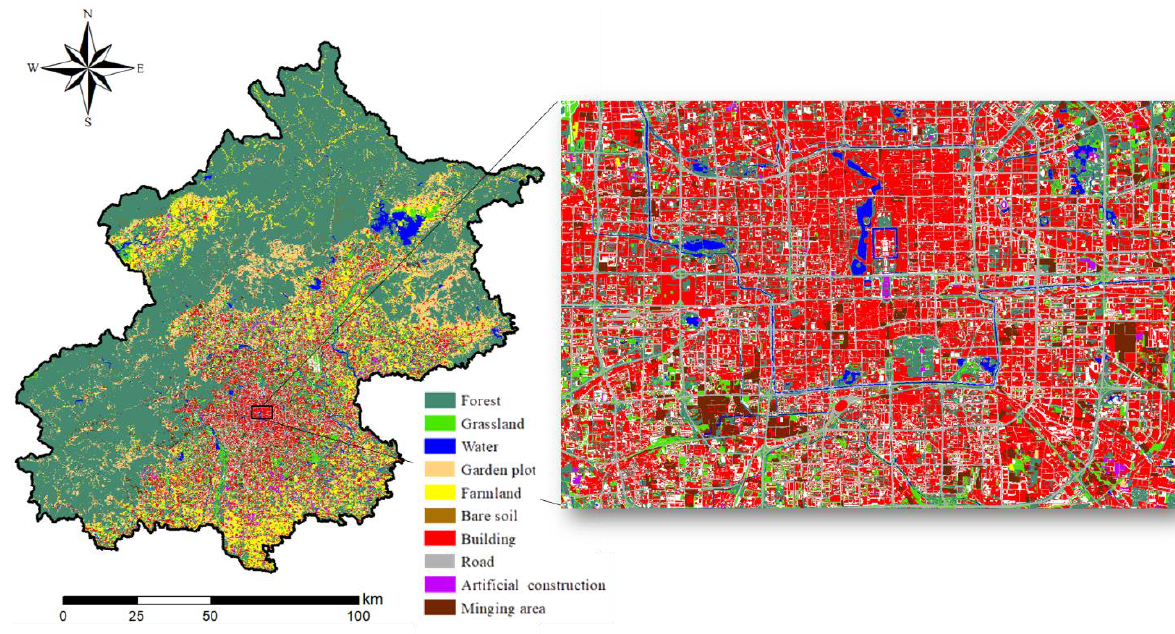
Figure 5. Land cover map of Beijing in 2015 (10 first-level